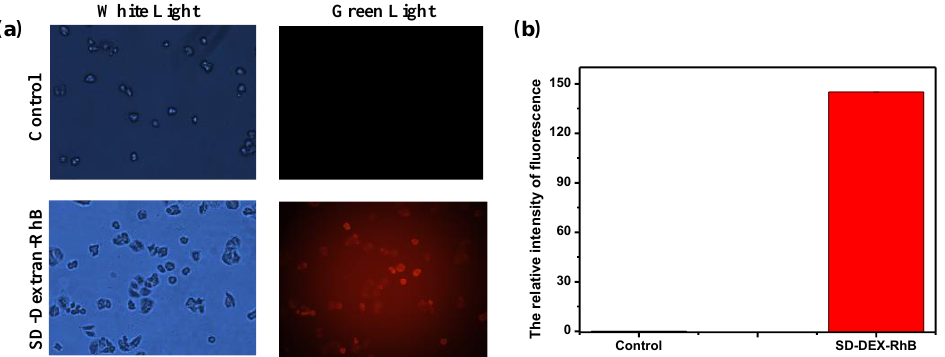
Figure 7. Fluorescent imaging ( a ) and relative fluorescent intensity ( b ) of SD-Dextran-RhB in HeLa cells.